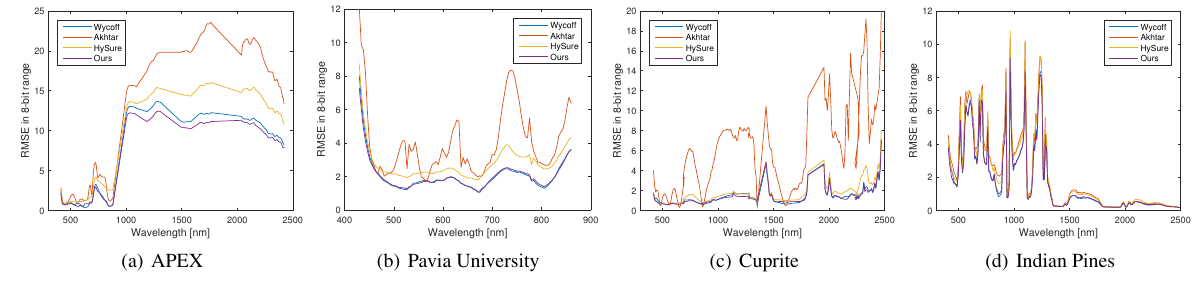
Figure 2. Per-pixel RMSE for all database images, sorted by magnitude.